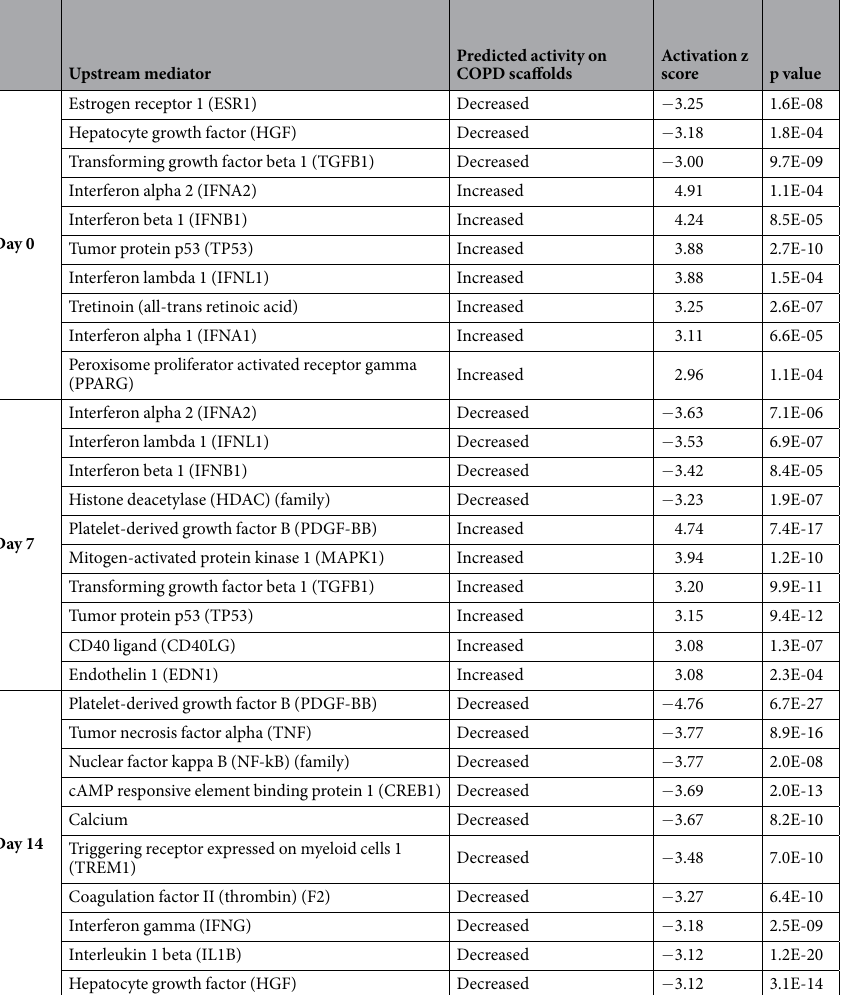
Table 2. Upstream mediators predicted to have a changed activity on COPD compared to normal bronchial scaffolds after 0, 7 and 14 days of differentiation. Shown are the 10 upstream mediators at each of the first three time points most likely to have a changed activity on COPD compared to normal scaffolds, based on the gene expression pattern in repopulated normal human bronchial epithelial cells (n = 3). Positive and negative activation z scores indicate increased and decreased activity, respectively, on COPD compared to normal scaffolds. The analysis was done using Ingenuity Pathway Analysis and p values were calculated with Fisher’s exact